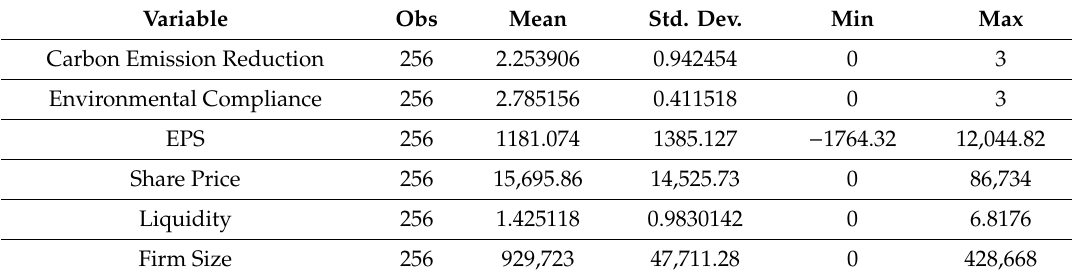
Table 3. Descriptive statistics.